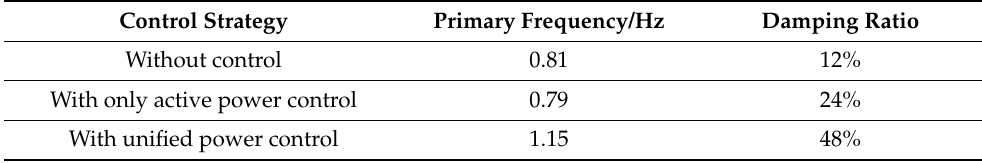
Table 3. The Damping ratio changing situations with different